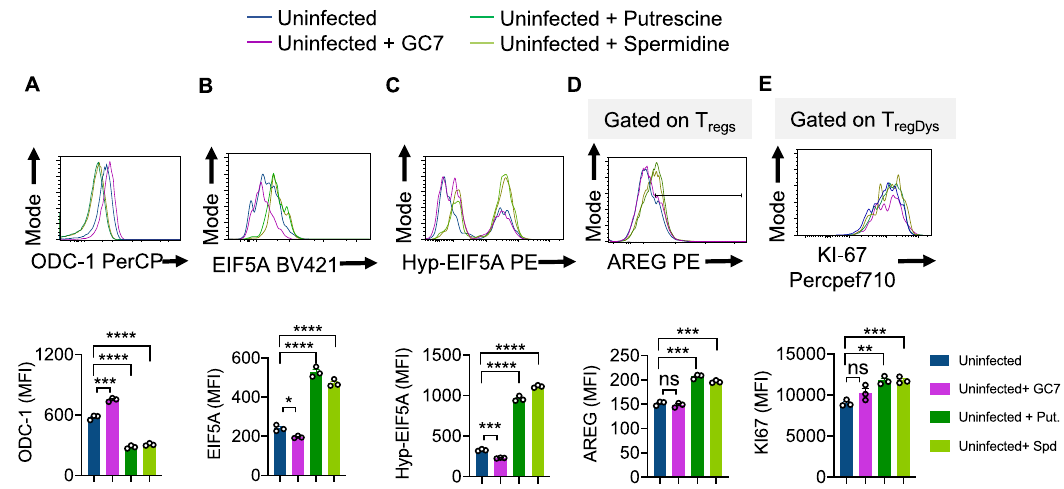
the fl ow cytometry analysis of ODC-1 ( A ), EIF5A ( B ), Hypusinated-EIF5A ( C ), AREG ( D ), and KI-67 ( E ) staining 6 days after stimulation. Means from triplicate experi- ments are plotted. **** P <0.0001; *** P <0.0006; ** P =0.002; * P <0.01; Two-tailed; Unpaired t test in A – E . Circles within box plots represent each replicate.